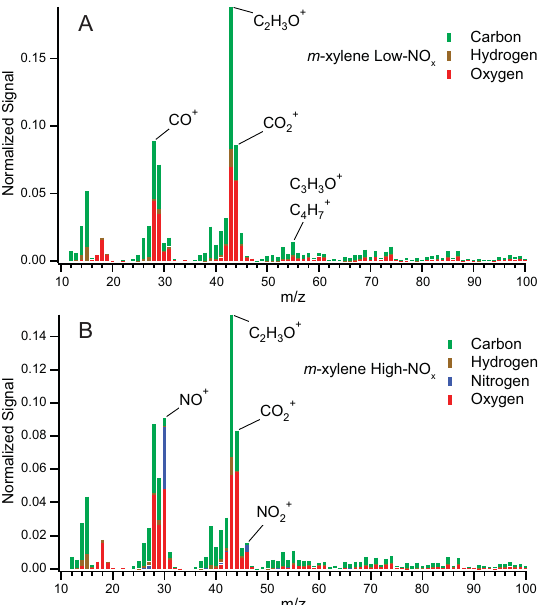
Fig. 9. High-resolution mass spectra of toluene SOA formed under low-NO x (A) and high-NO x (B) conditions with elemental contri- butions to each mass-to-charge ratio shown. Spectra are taken at the peak of SOA growth.